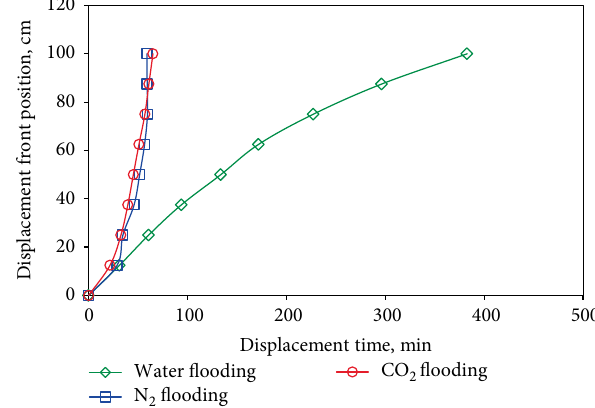
Figure 19: The displacement front velocity of water, CO